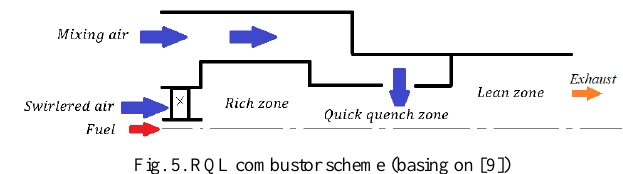
Fig. 5. RQL combustor scheme (basing on [9])